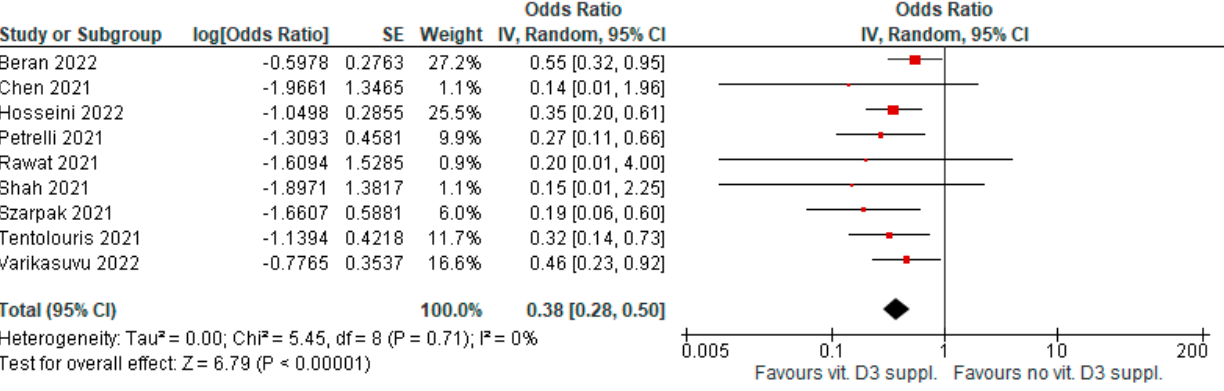
Figure 5. Forest plot showing results for the association of vitamin D3 supplementation and COVID- 19 severity.